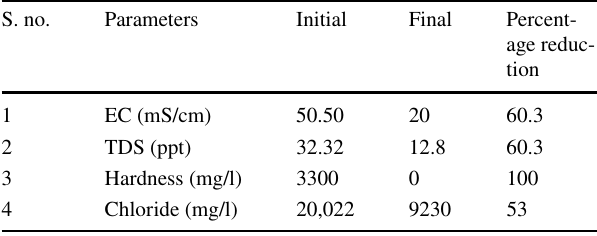
Table 4 Performance of EBCR in removing salts from Sample I S. no.